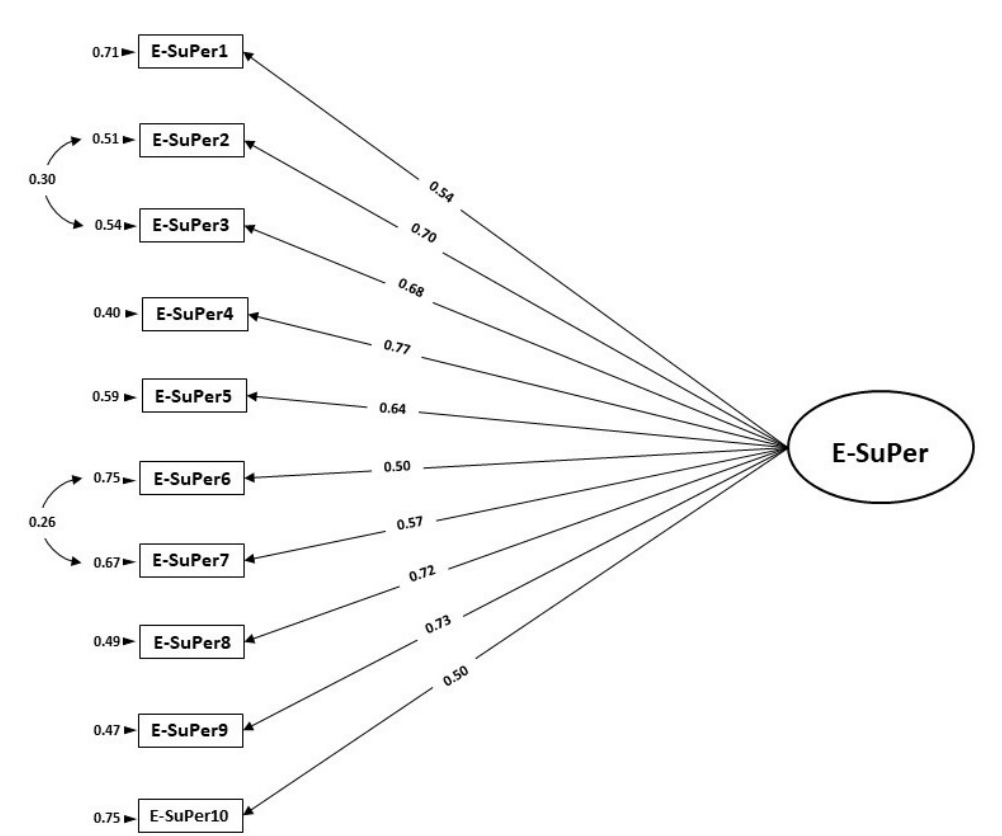
Figure 2. Final CFA model M 2 and standardized factor loadings for the E ‐ SuPer instrument (Sample B; n = 160).